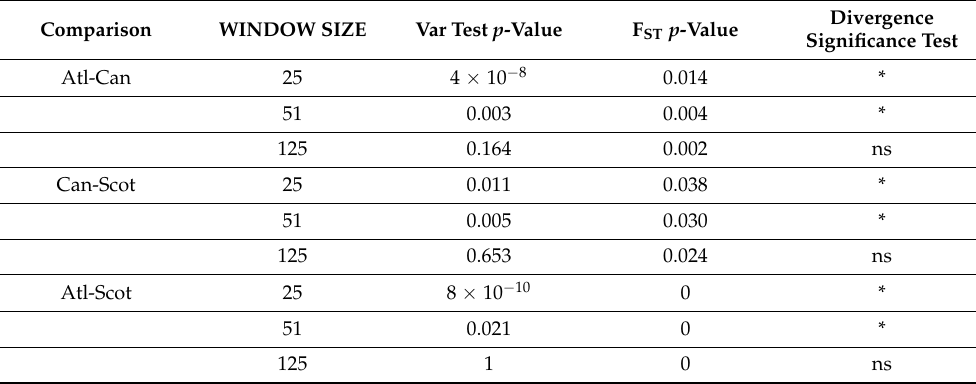
Table 5. Homogeneity variance test for divergent selection from the new version of the HacDivSel program. Var test p value: The p -value of the within-population variance homogeneity F test. The within-population variance homogeneity test implies two comparisons, one for each population, and two p values are obtained. The minimum p -value obtained is given in the table. Comparison WINDOW SIZE Var Test p -Value F ST p -Value